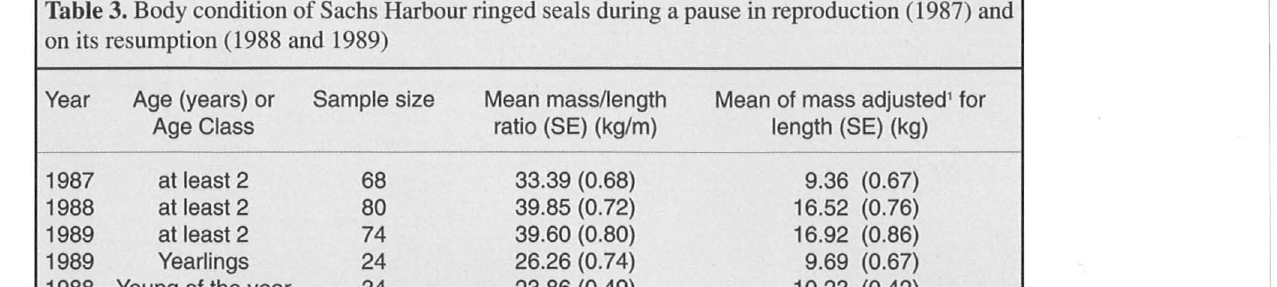
Table 3. Body condition of Sachs Harbour ringed seals during a pause in reproduction (1987) and on its resumption (1988 and 1989)